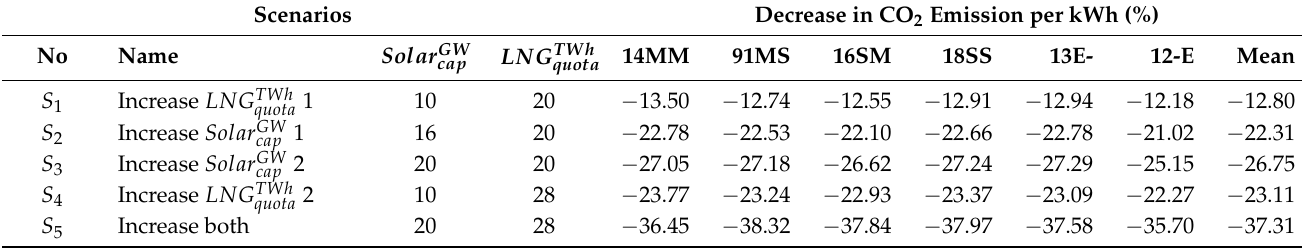
Table 11. CO 2 emission decrease from the reference